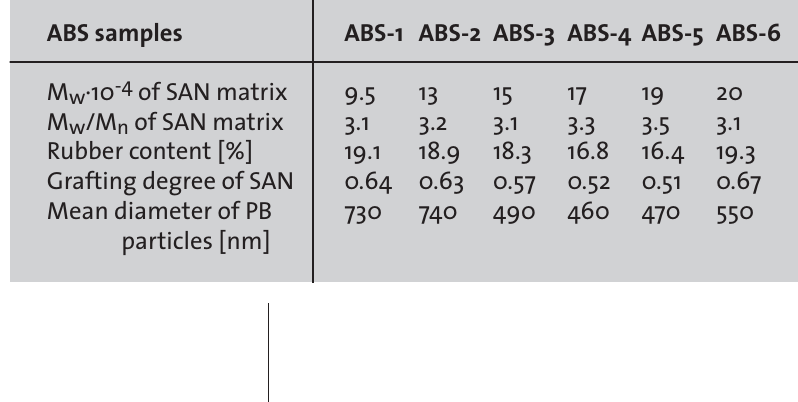
Table 1: Molecular characteristics of ABS